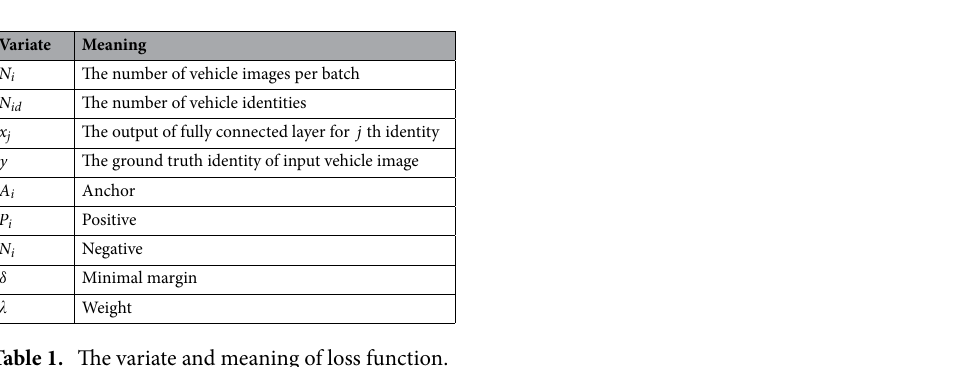
Table 1. The variate and meaning of loss